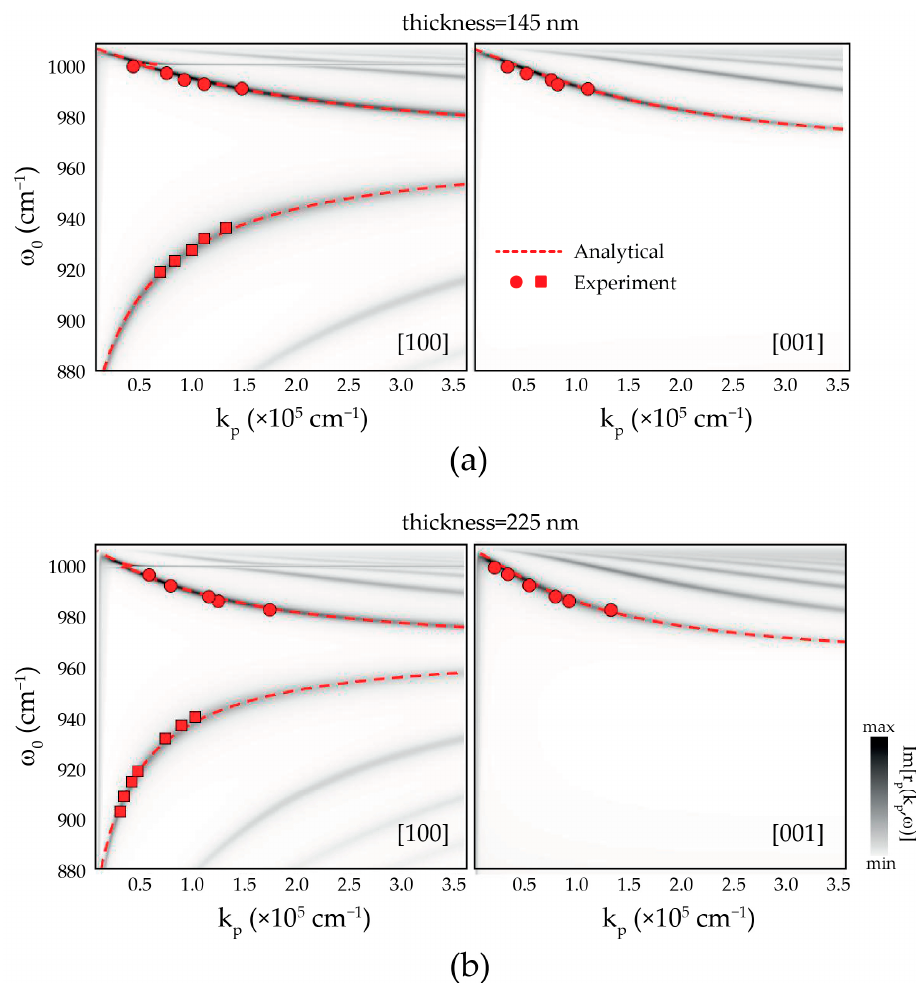
Figure 2. Dispersion of PhPs on thin α -MoO 3 flakes on top of SiO 2 substrates. Transfer-matrix cal-